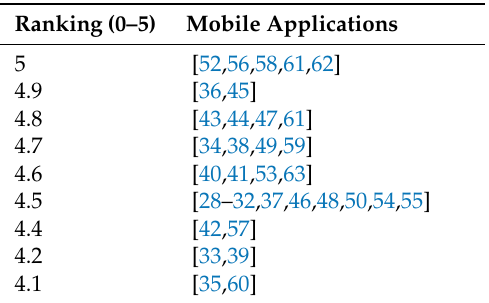
Table 2. Distribution of mobile application by user